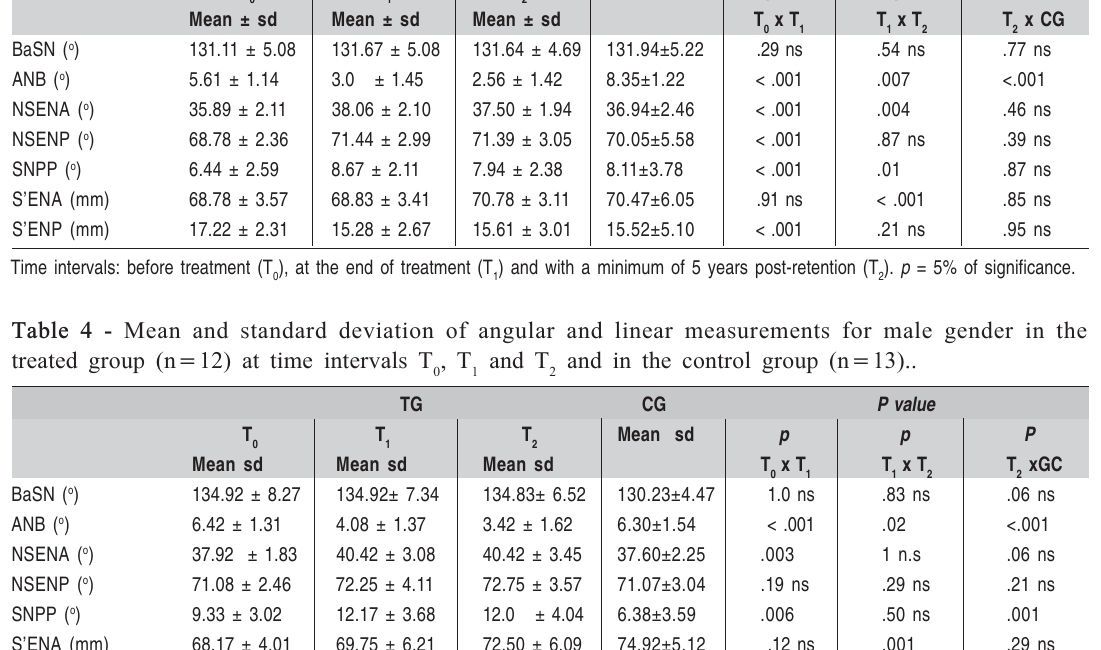
), at the end of treatment (T 0